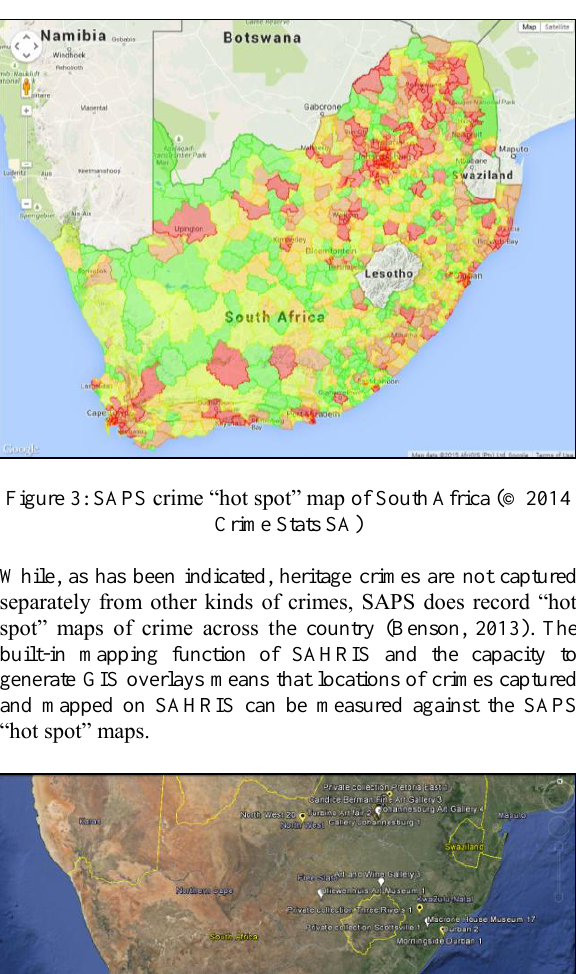
Figure 1: Example of a heritage crime case on SAHRIS